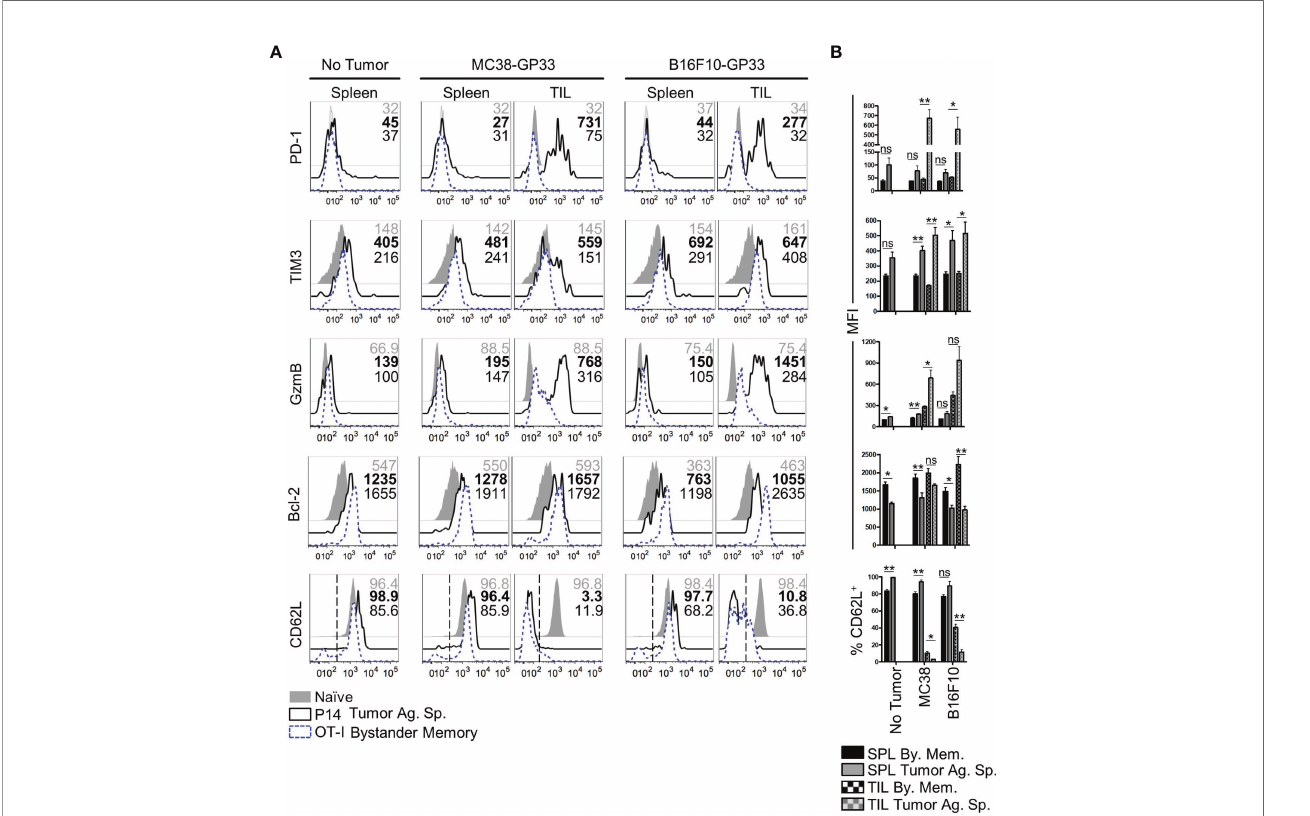
FIGURE 2 | Phenotype of bystander memory CD8 T cells in tumor microenvironment. (A) Histograms are gated on CD8 T cells and show the respective markers in spleen of naïve (gray), tumor antigen speci fi c (solid, black), or bystander memory (dashed, blue) CD8 T cells. Numbers show MFI of given markers for naïve (gray), tumor antigen speci fi c (bold), and bystander memory (black) T cells for spleen and TIL taken from B6 mice with no tumor, MC38-GP33 tumor, or B16.F10-GP33 tumor. Bar charts to the right (B) show the average MFI or average percent positive with SEM for each population of CD8 T cells. Representative plots are shown from N=5 mice per group. *p < 0.05. **p < 0.01 as determine by paired T-test. Data is representative of 3 independent experiments. ns, non-signi fi